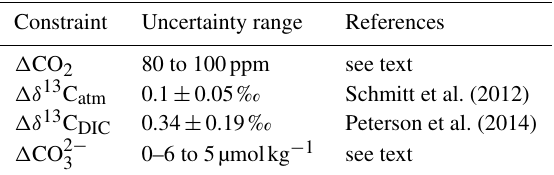
Table 3. Overview of the four proxy-based constraints representing change ( (cid:49) ) between PI minus LGM. LGM refers to the period 20 to 19ka for the ice core and to the period 23 to 19ka for the ocean sediment data. Similarly, PI refers to 500 to 200BP for the ice core data and 6000 to 200BP and 8 to 6ka for marine δ 13 C and CO 2 − respectively. The assumed uncertainty range in (cid:49) CO 2 is consid- ered to be wider than the uncertainty from the ice core data. This is to avoid overfitting and taking into account uncertainties in the emulator introduced in Sect.